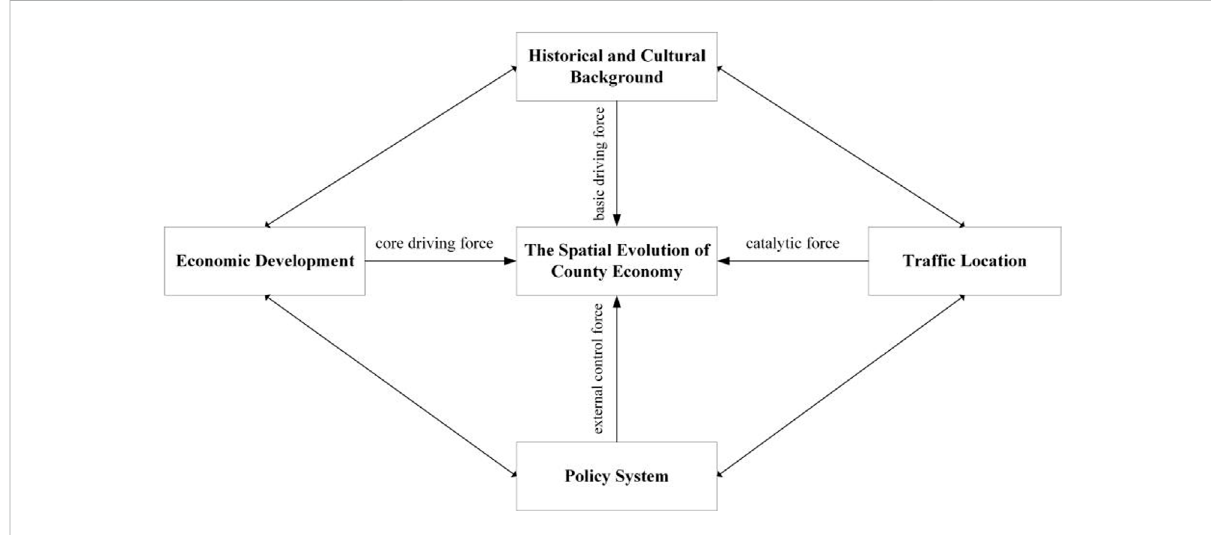
FIGURE 10 Driving forces of the spatial evolution of the county economy in Hubei province.